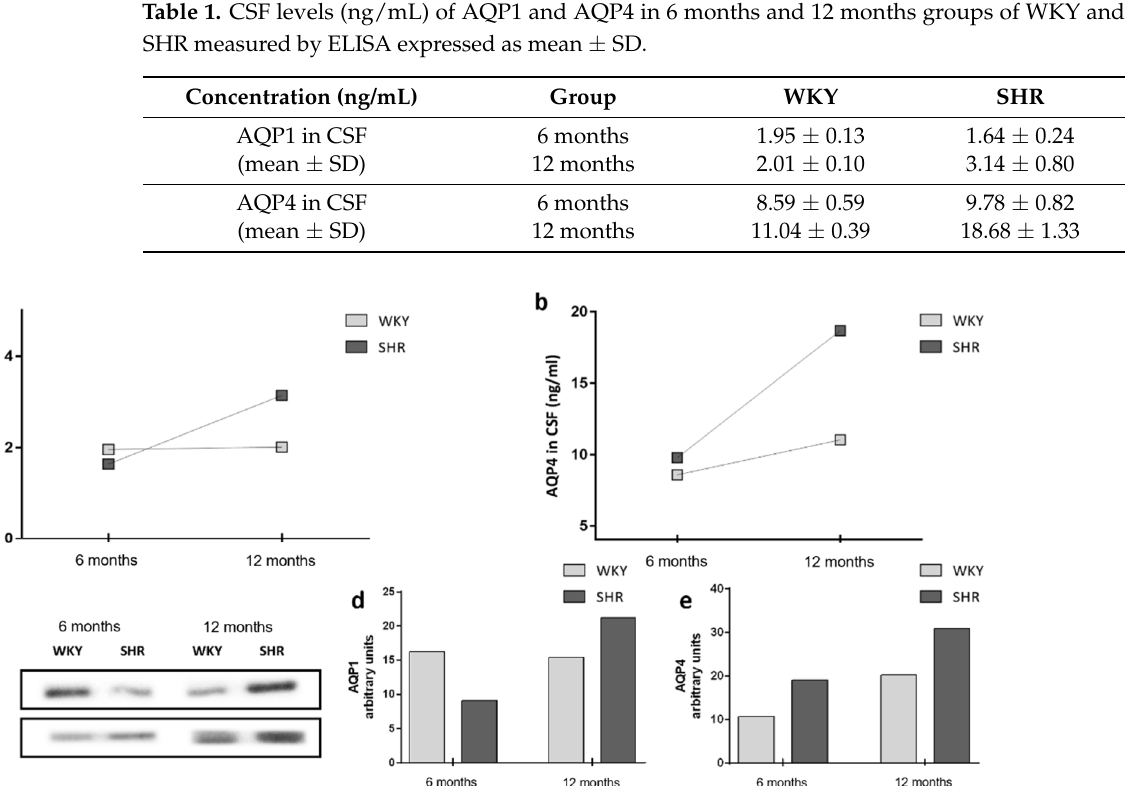
Figure 4. Variation in the timeline of AQP values in CSF. Representation of age-related mean values of AQP1 and AQP4 in CSF of WKY and SHR are shown in ( a ) and ( b ), respectively. Expression of AQP1 and AQP4 in CSF ( c ). Graphic representation of values of AQP1 and AQP4 in CSF by Western blot ( d , e ).